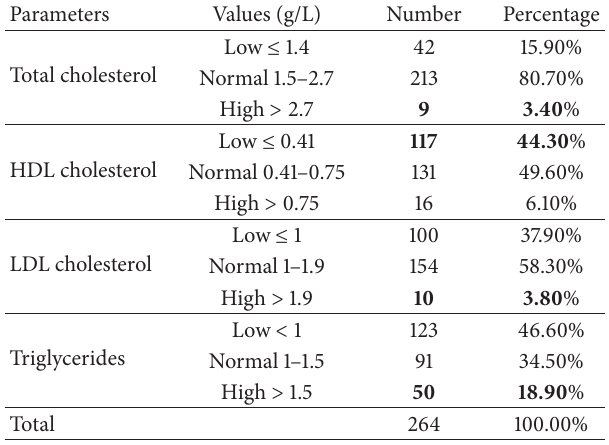
Table 1: Lipid profile abnormalities in the studied